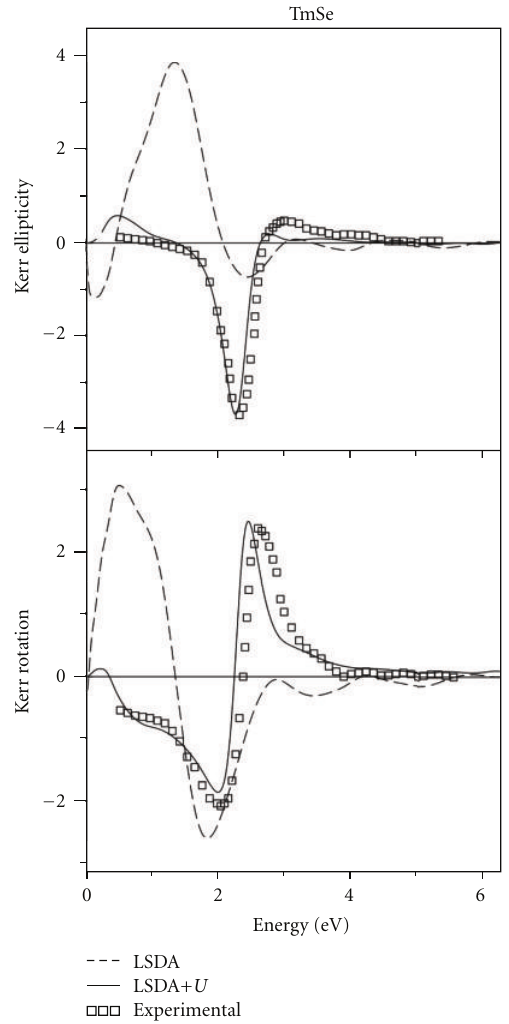
Figure 74: Calculated Kerr rotation and Kerr ellipticity spectra (in degrees) for TmSe in the LSDA (dashed line) and LSDA+ U (full line) approximations [384] compared with experimental data (open squares)